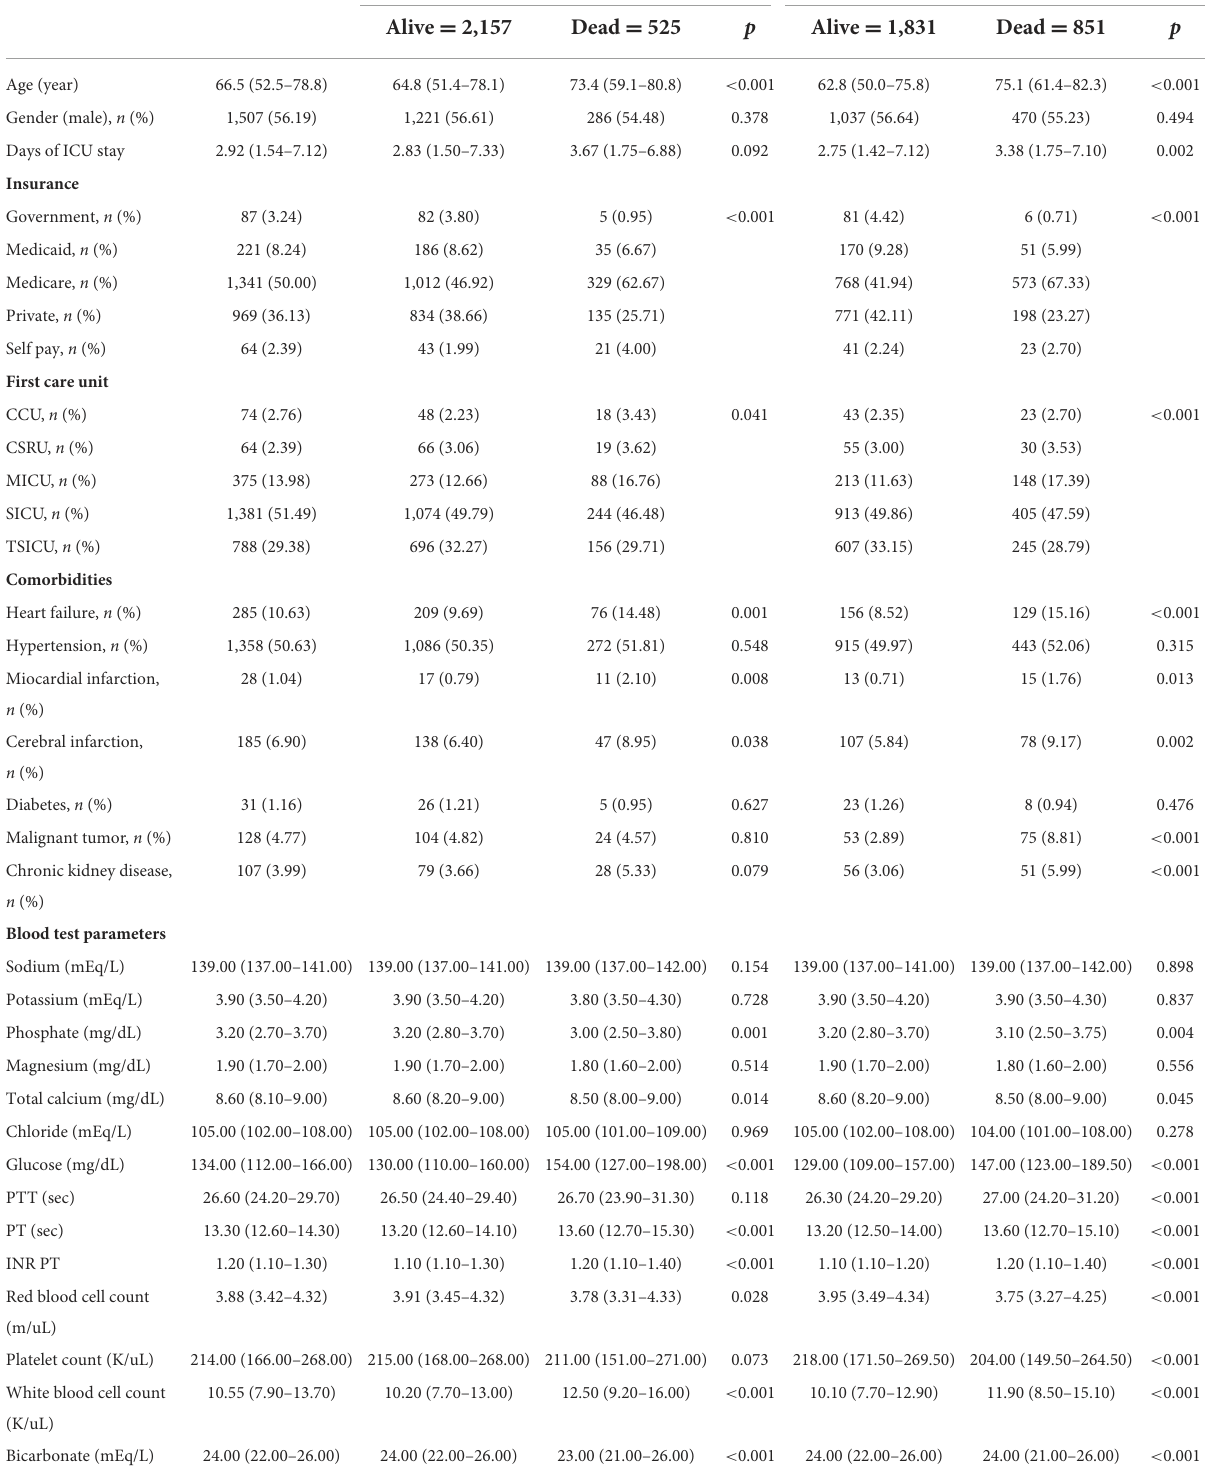
TABLE 1 Clinical characteristics of ICU patients with intracranial hemorrhage at